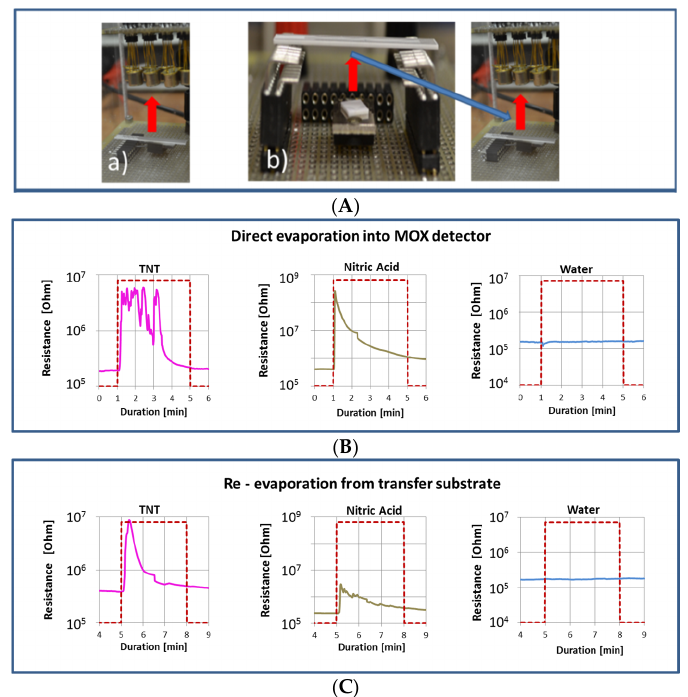
Figure 13. ( A ) One ‐ step and two ‐ step thermal solid vapor conversion processes; ( B ) sensor responses to TNT, HNO 3 and water upon first evaporation; ( C ) sensor responses to TNT, HNO 3 and water upon re ‐ evaporation from the transfer